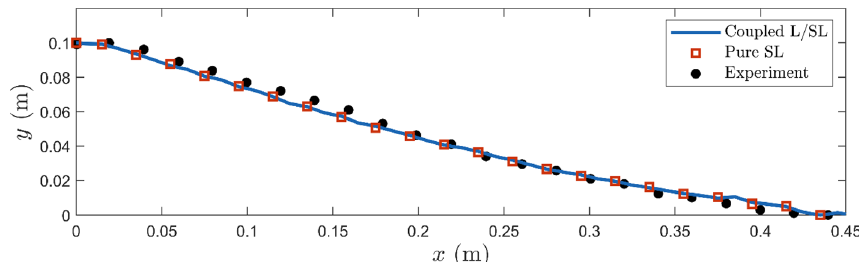
Fig. 14 Comparison of surface configurations obtained experimentally and numerically